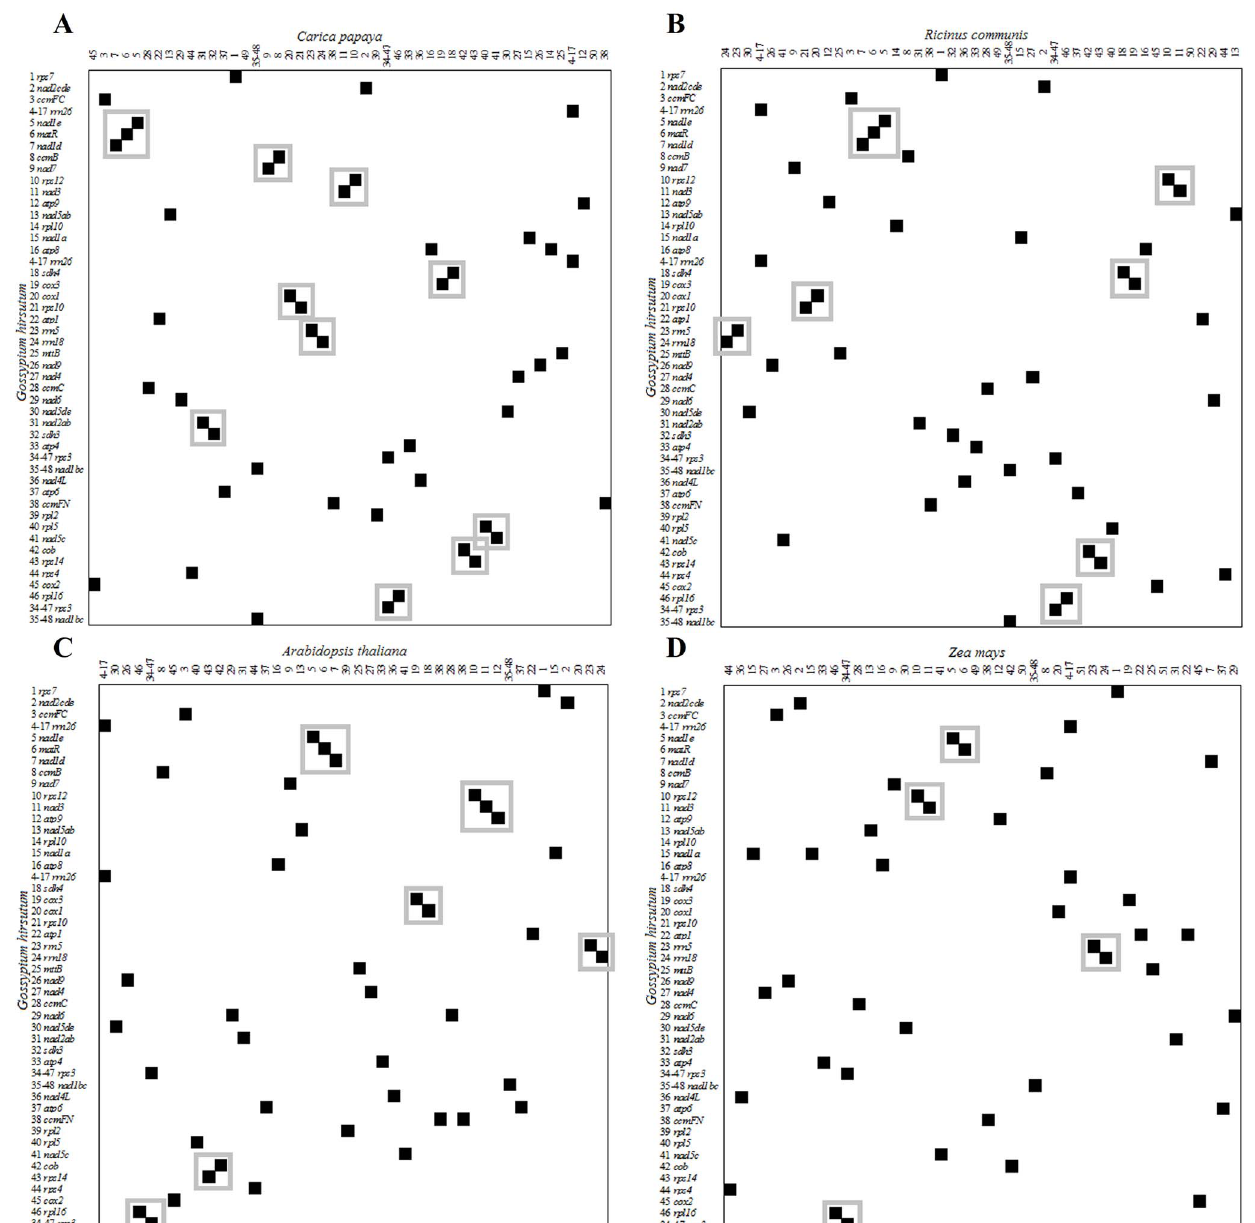
Figure 3. Gene order and existed clusters between the mitochondrial gene maps of Gossypium and other four angiosperms. Gene order of the protein-coding and rRNA-coding genes, and the former’s trans-spliced exons were based on the mt genome of G. hirsutum arranging from top to bottom. Genes of other four mt genomes were indicated by the corresponding numbers given to cotton genes listed on the left margin. Duplicate genes carried the same number. From left to right for (A) C. papaya , (B) R. communis , (C) A. thaliana and (D) Z. mays .